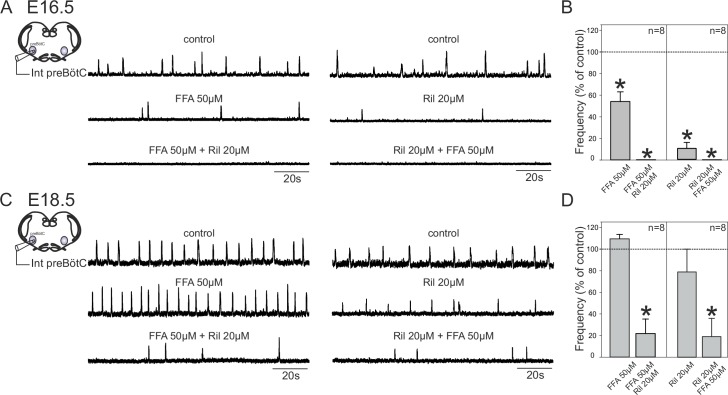
Mechanisms for inspiratory network rhythmogenesis change during embryonic development.(A) Schematic representation of an in vitro slice preparation used for electrophysiological recording of spontaneous preBötC network activity (integrated traces, Int preBötC) in control conditions (top traces) or in the presence of either FFA (50 µM, middle trace, left) or Ril (20 µM, middle trace, right) alone or in combination (bottom traces) at E16.5. (B) Bar histograms representing the percentages of cycle frequency change (mean ± SEM) compared to control under the different pharmacological conditions illustrated in A. Asterisks indicate significant differences (t-test, p<0.05); n = number of experiments in each case. (C,D) same layout as (A,B) for experiments performed at E18.5. Note that unlike at E16.5 where both FFA and Ril significantly reduced rhythmogenesis, blockade of either ICAN or INaP alone did not significantly perturb rhythm generation at E18.5. Also, blockade of both conductances at E16.5 was sufficient to completely suppress rhythm generation, but not at E18.5.